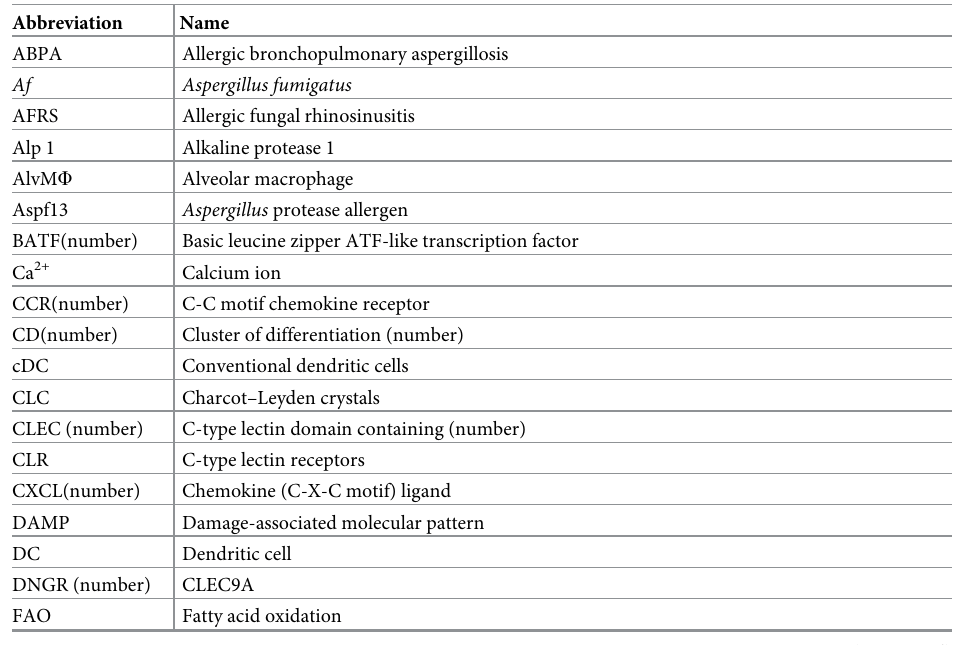
Table 1. List of abbreviations and